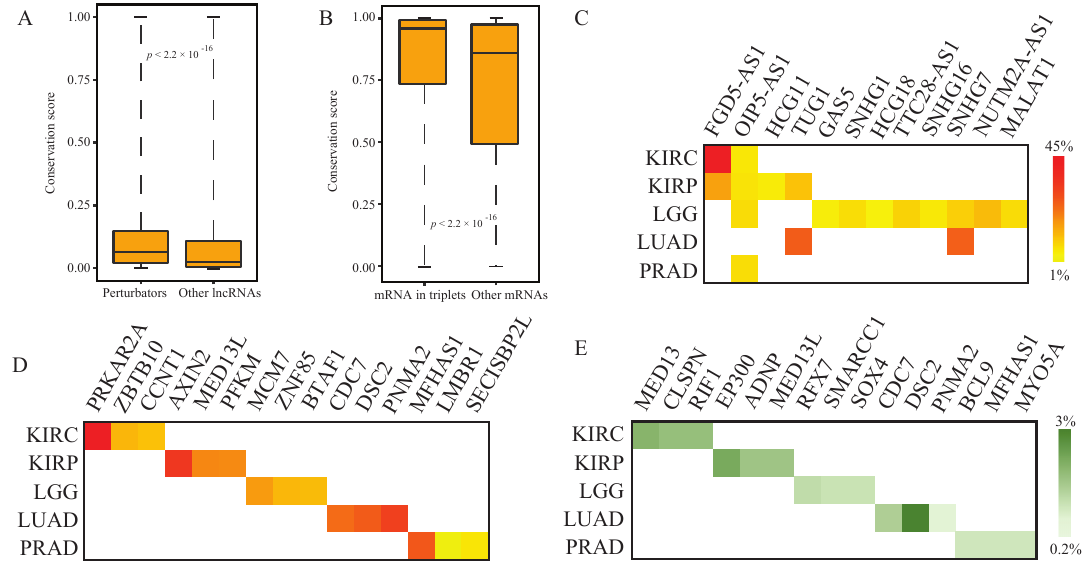
Figure 2. LncRNA perturbators show significantly higher evolutionary conservation than the other lncRNAs. ( A ) The evolutionary conservation score of lncRNA perturbators and other lncRNAs. ( B ) The evolutionary conservation score of lncRNA-perturbated mRNAs and other